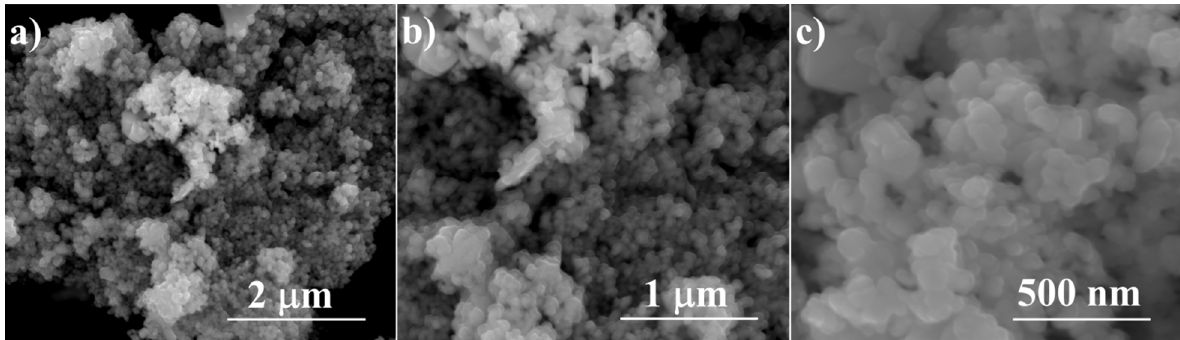
Figure 2. SEM photographs of Cu 2 Se powders after synthesis at magnification: ( a ) 50.000× ( b ) 100.000× and ( c ) 200.000×.